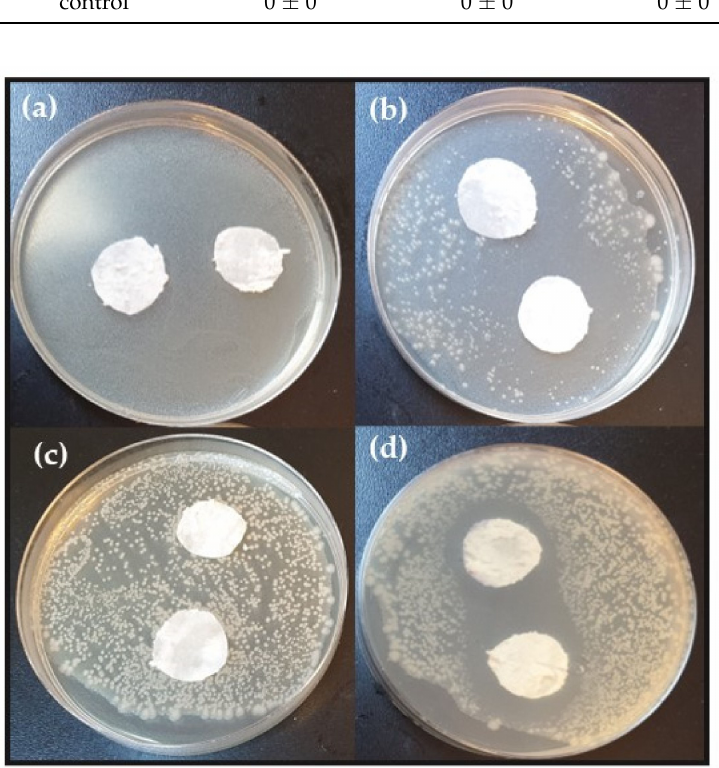
Figure 2. Effects of citral, nerol and carvacrol on the growth of E. coli: ( a ) 0.5% citral, ( b ) 2.0% nerol ( c ) 1% geraniol ( d ) 3.0%